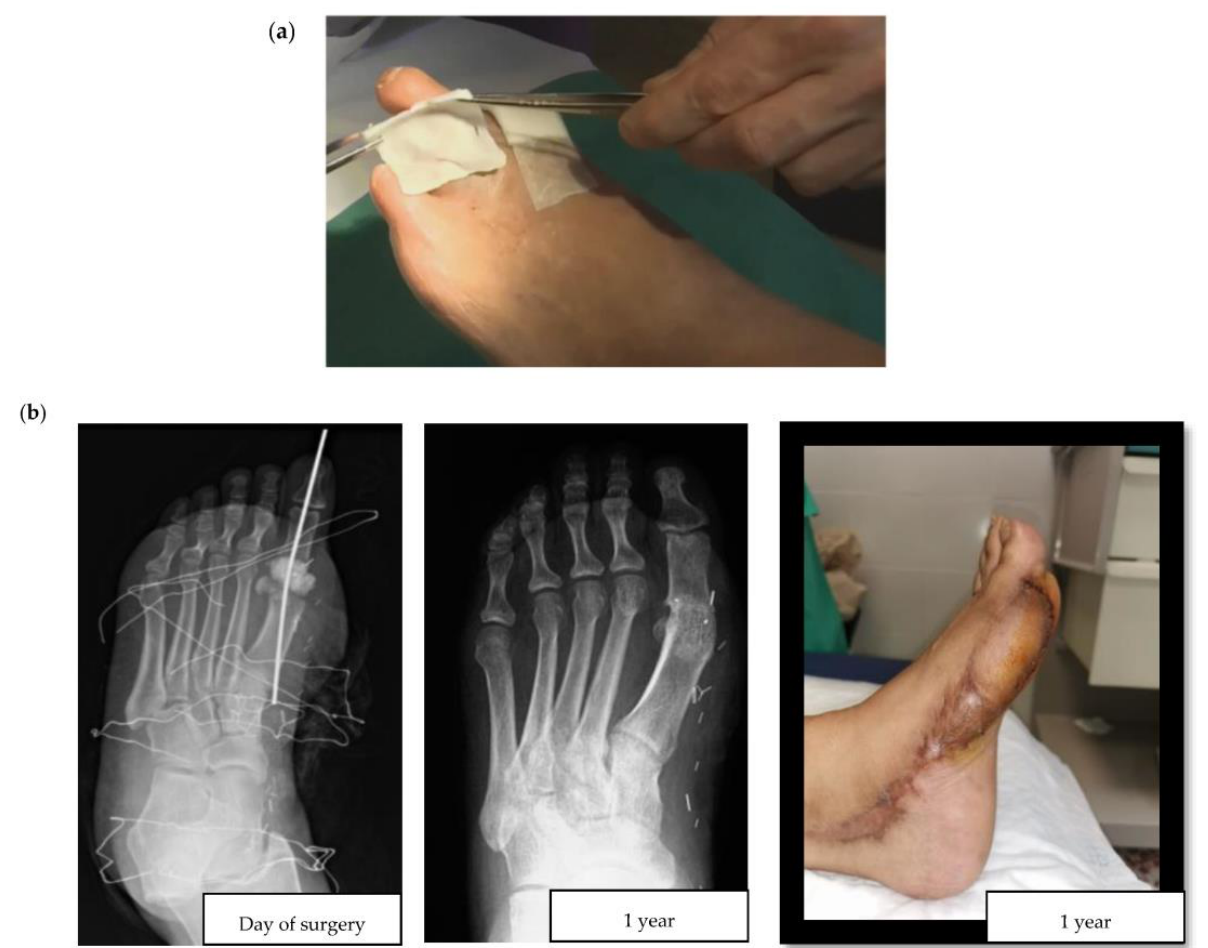
Figure 1. ( a ) Application of a collagen sponge on a diabetic foot wound (courtesy of Dr. Ilker Uçkay) ; ( b ) Clinical case of a hallux valgus osteomyelitis with bone resection, filling with Cerament G ® and a flap. We can observe bone osteointegration 1 year later (courtesy of Dr. Alberto Pérez Fernández).